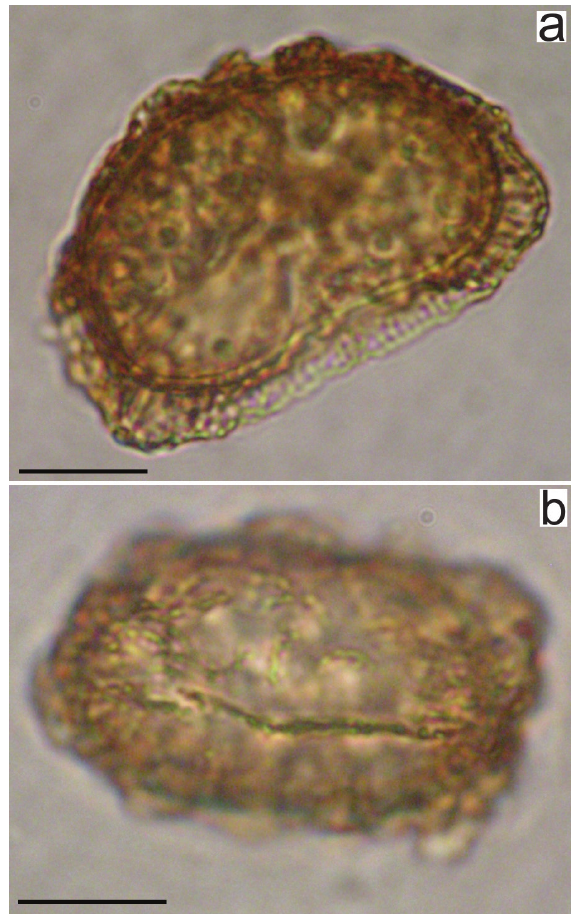
Figure 3. Spores of A. yabotiense as seen with a light microscope at 100× magnification. a. Equatorial view. b. Distal